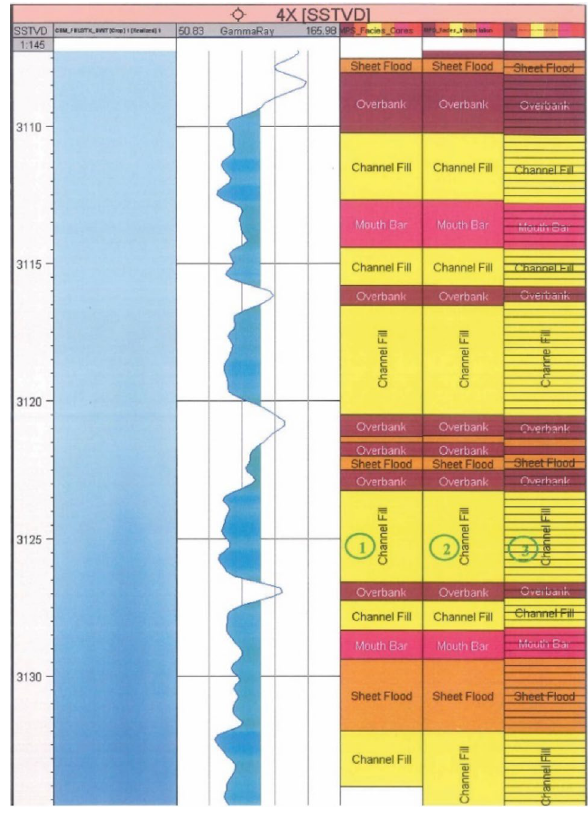
Fig. 12 Comparison of facies in well by core (1), after interpreted by gamma ray (2), and after assigned in model